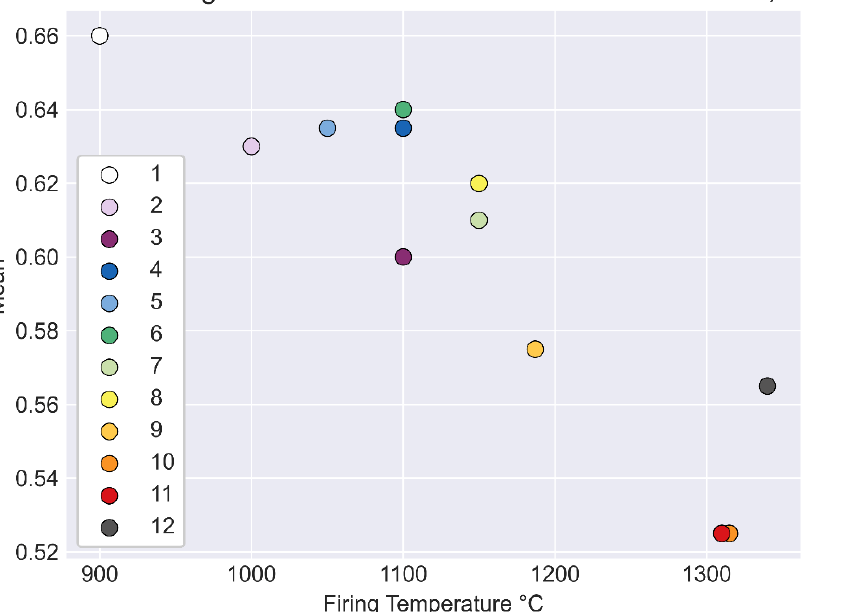
Figure 10. Pore mean Feret diameter increases with firing temperature. Points are mean of 2.